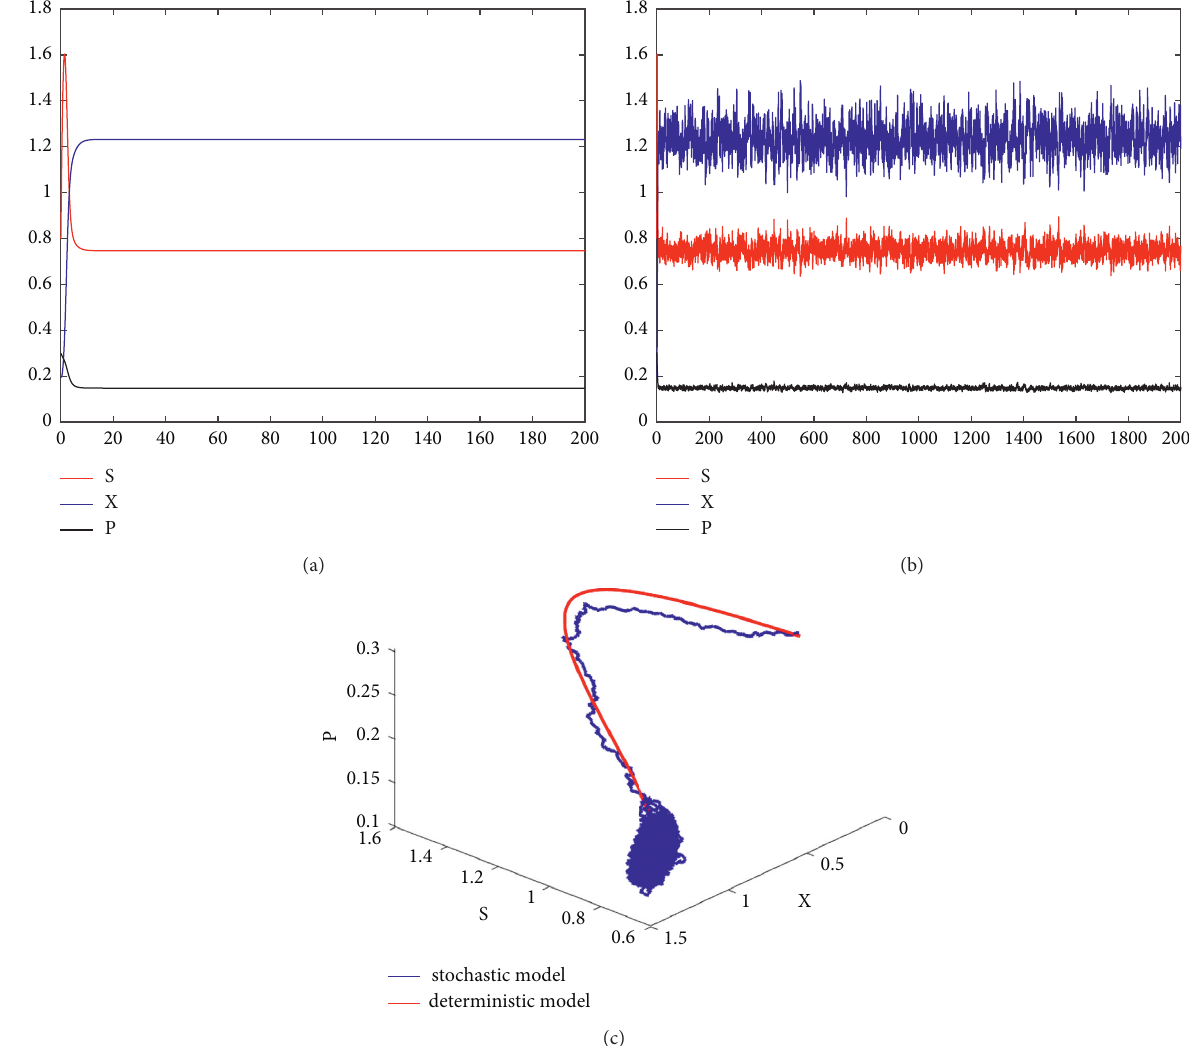
Figure 2: The comparison of solutions for system (1) and system (4). (a) The solutions of system (1) with τ � 0, (b) the solutions of system (4), and (c) the comparison of phase portrait for system (1) and system